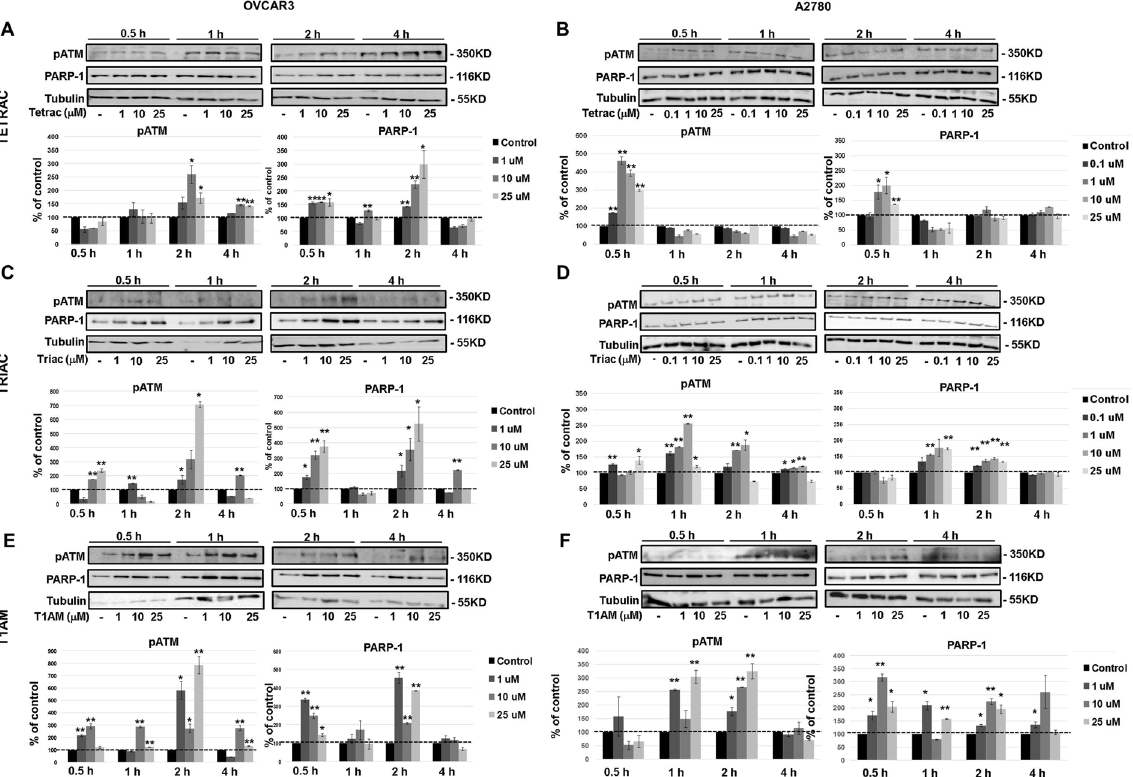
Figure 8. Thyroid hormone derivatives induce ATM phosphorylation and PARP-1. OVCAR3 and A2780 cells were treated for 0.5–4 hours with 0.1, 1, 10 or 25 μ M ( A , B ) tetrac ( C , D ) triac and ( E , F ) T1AM, respectively. ATM and PARP-1 were analyzed by Western blots. Representative blot of two independent experiments is presented. * p < 0.05, ** p <